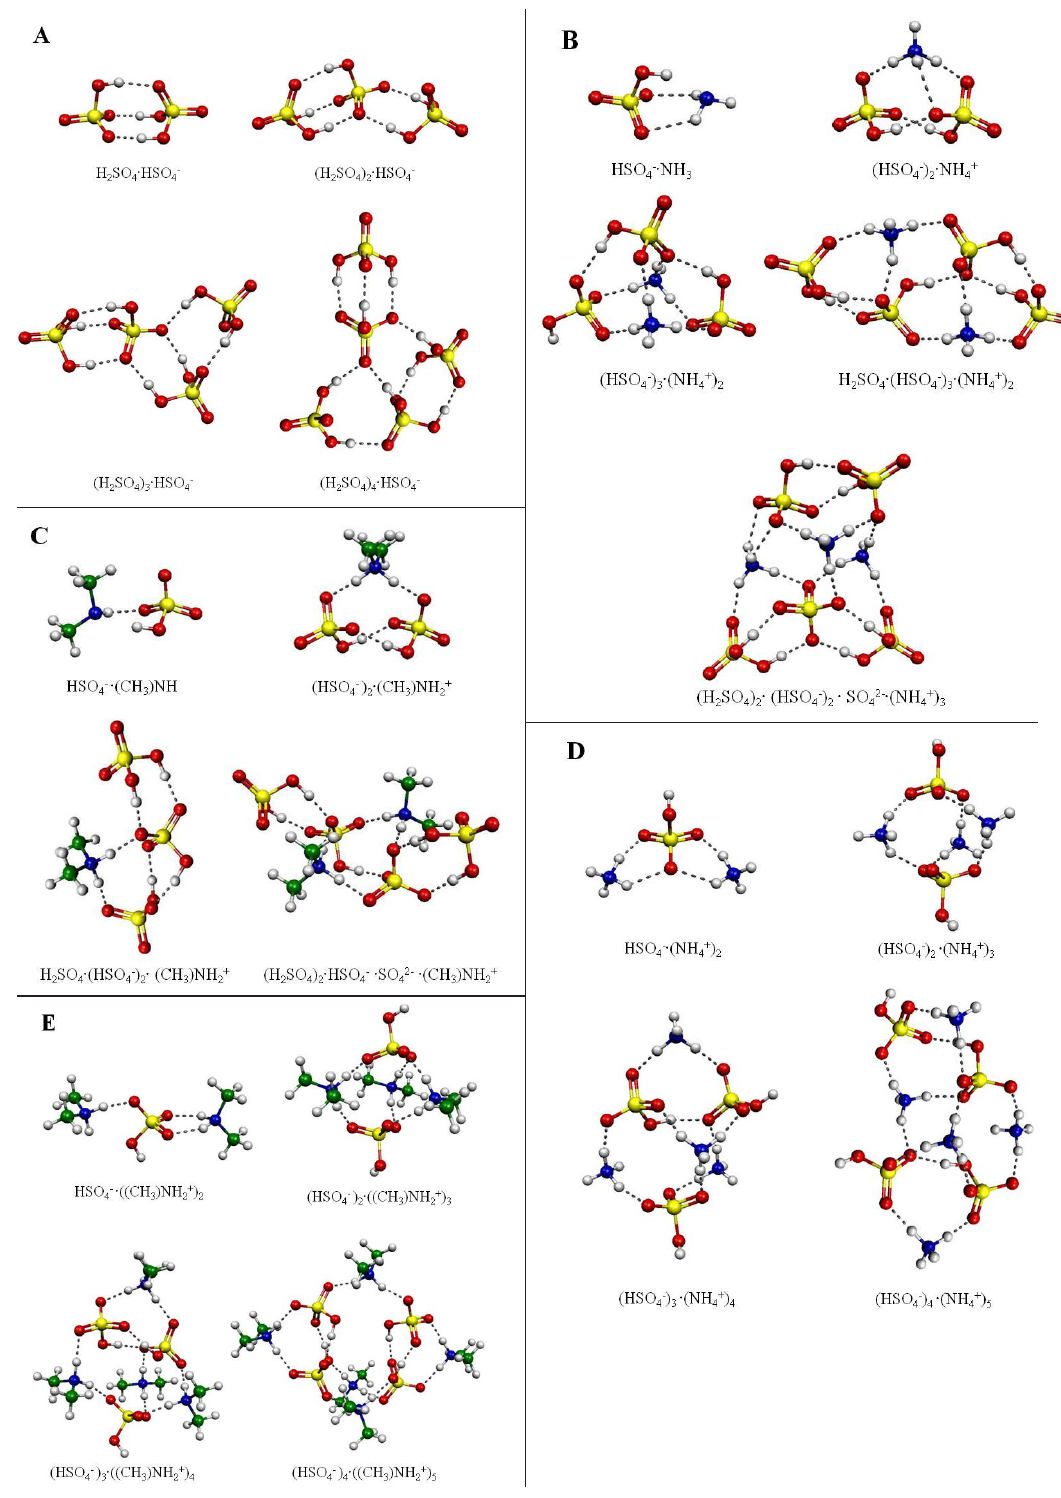
Figure 1. Structures of clusters with one to four/five sulfuric acid molecules and the most favorable number of base molecules (those with the lowest total evaporation rate) for (A) negatively charged sulfuric acid clusters, (B) negatively charged ammonia-containing clusters, (C) negatively charged DMA-containing clusters, (D) positively charged ammonia-containing clusters and (E) positively charged DMA- containing clusters. Red spheres represent oxygen atoms, yellow spheres represent sulfur atoms, blue spheres represent nitrogen atoms, white spheres represent hydrogen atoms and green spheres represent carbon